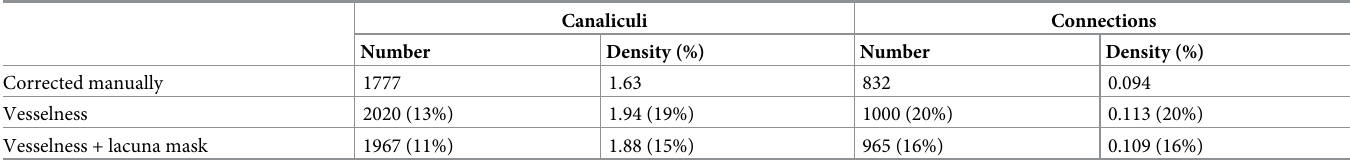
Table 1. Uncertainty estimation for the proposed image processing methods. Two parameters are used to characterize the canalicular network: the density of canalicular porosity, and the volumetric density of connections. Skeletons obtained with different processing methods are compared with a reference skeleton that was manually cor- rected to match the network visible on the original THG image. In each case, the full volume is used, or a part corresponding to the position of the lacuna is removed from the analysis. % uncertainty indicated in parenthesis.